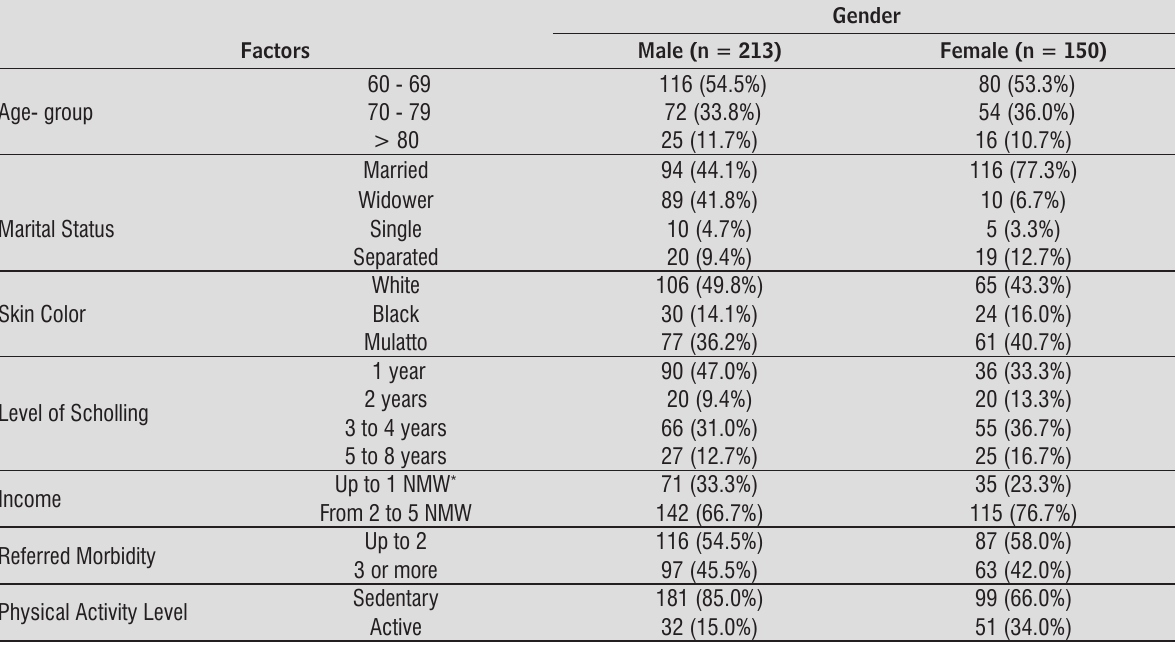
Table 1 - Distribution of absolute and relative frequencies of sociodemographic characteristics, referred morbidity and physical activity level of the elderly participants